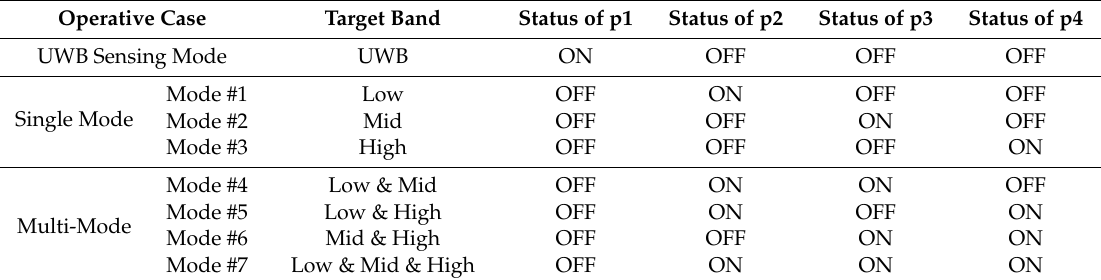
Table 1. Communication modes depending on the on–o ff status of the ports.